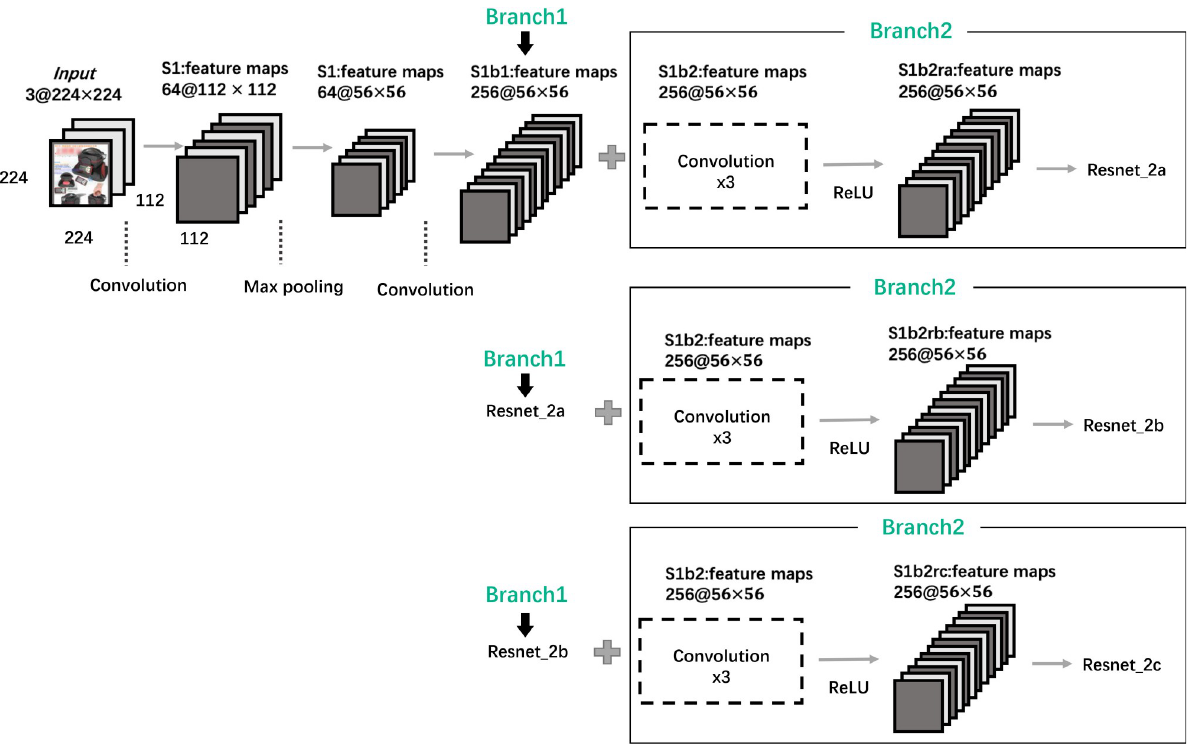
Fig 2. Architecture of the ResNet-50 network. Each plane is a feature map.